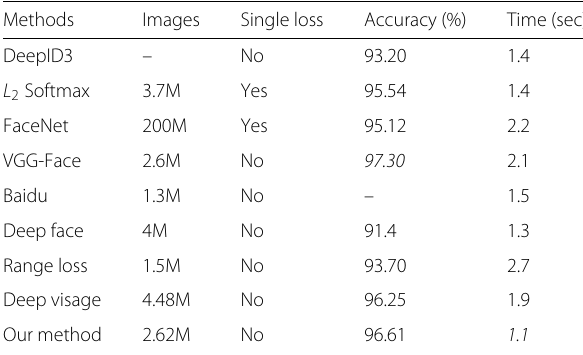
Table 3 Face verification performances on YTF